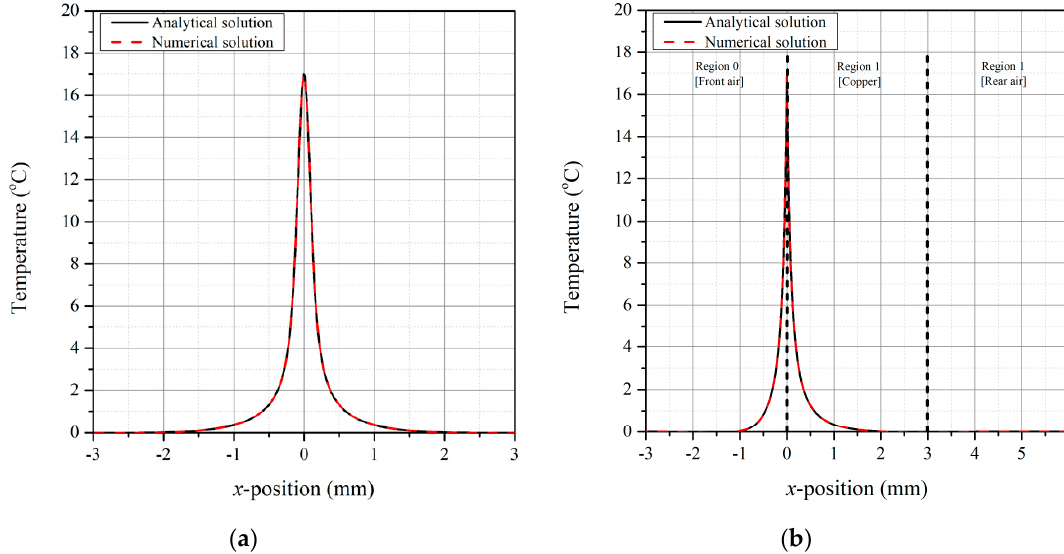
Figure 4. Comparison of analytical and numerical solutions. ( a ) Temperature change in x-direction ( 𝑦 = 0, 𝑧 = 0 ). ( b ) Temperature change in z-direction ( 𝑥 = 0, 𝑦 = 0 ).